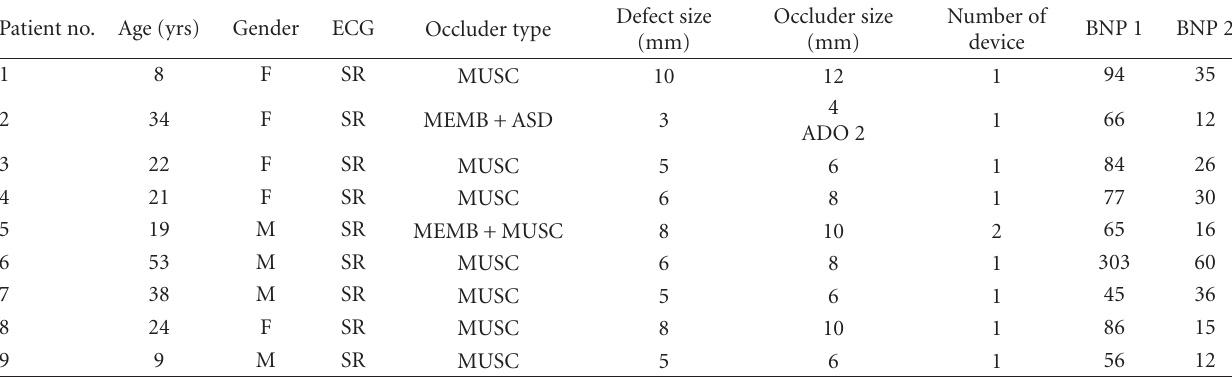
Table 1: Patient characteristics and